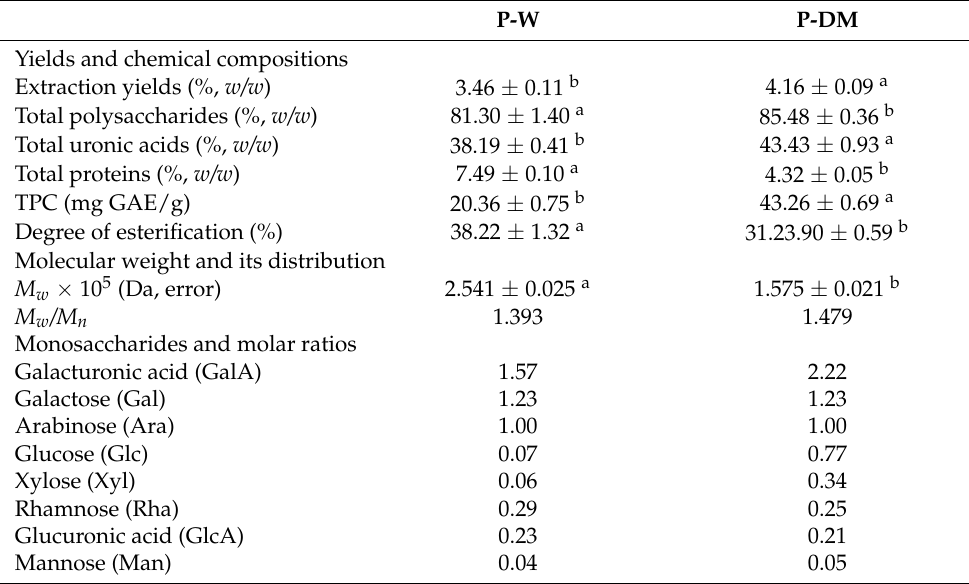
Table 3. Comparison of chemical compositions, molecular weight ( M w ), polydispersity ( M w /M n ), and molar ratios of constituent monosaccharides of polysaccharides extracted by hot water extraction and microwave-assisted deep eutectic solvent extraction. P-W P-DM Yields and chemical compositions Extraction yields (%, w/w